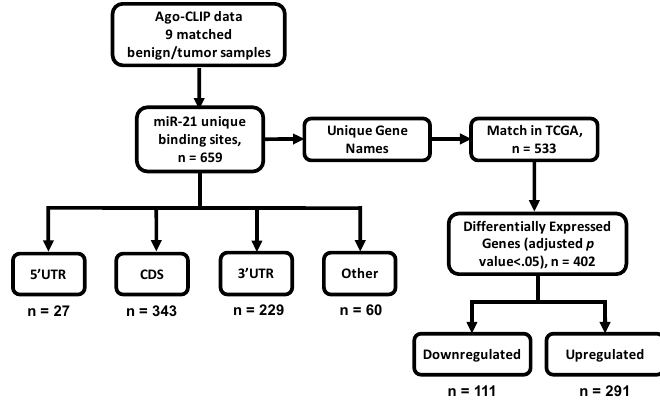
Figure 1. Workflow for the selection and analysis of microRNA-21 (miR-21) targets. Unique miR-21 targets ( n = 659) were identified using high-throughput sequencing of RNA isolated by cross-linking and immunoprecipitation of Argonaute (Ago-CLIP) data generated from matching benign liver and tumor tissues isolated from nine hepatocellular carcinoma (HCC) patients (GSE97061) [21]. Targets were sorted based on annotation of target loci: 5 (cid:48) untranslated region [5 (cid:48) UTR], coding sequence [CDS], 3 (cid:48)